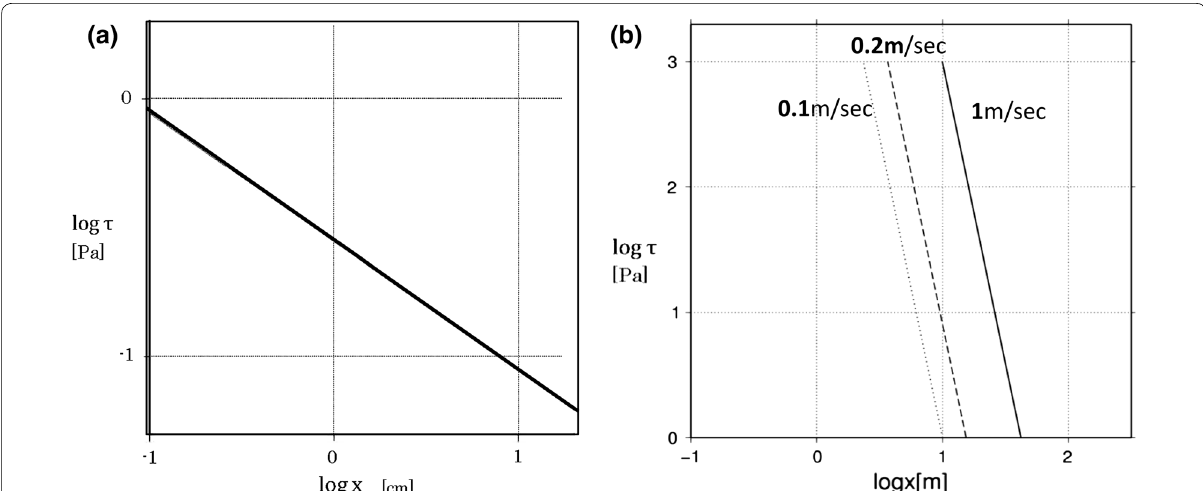
Fig. 7 a Shear stress measured for the semi‑infinite plate using water. “ x ” represents the distance from the tip of the flat plate in log–log scale. b Shear stress measured for the infinite plate using edible sauce. This figure shows how the shear stress changes as a fluid particle in the sauce moves “ x ” meters from its original point at flow rates of 0.1, 0.2, and 1 m/sec in the log–log